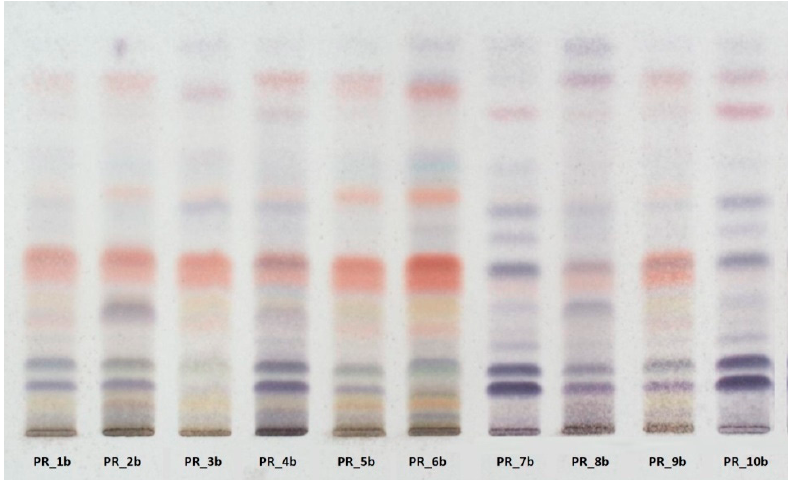
Figure 1. High-performance thin-layer chromatography (HPTLC) revealed high variability in the metabolic profile of the methanolic extracts.